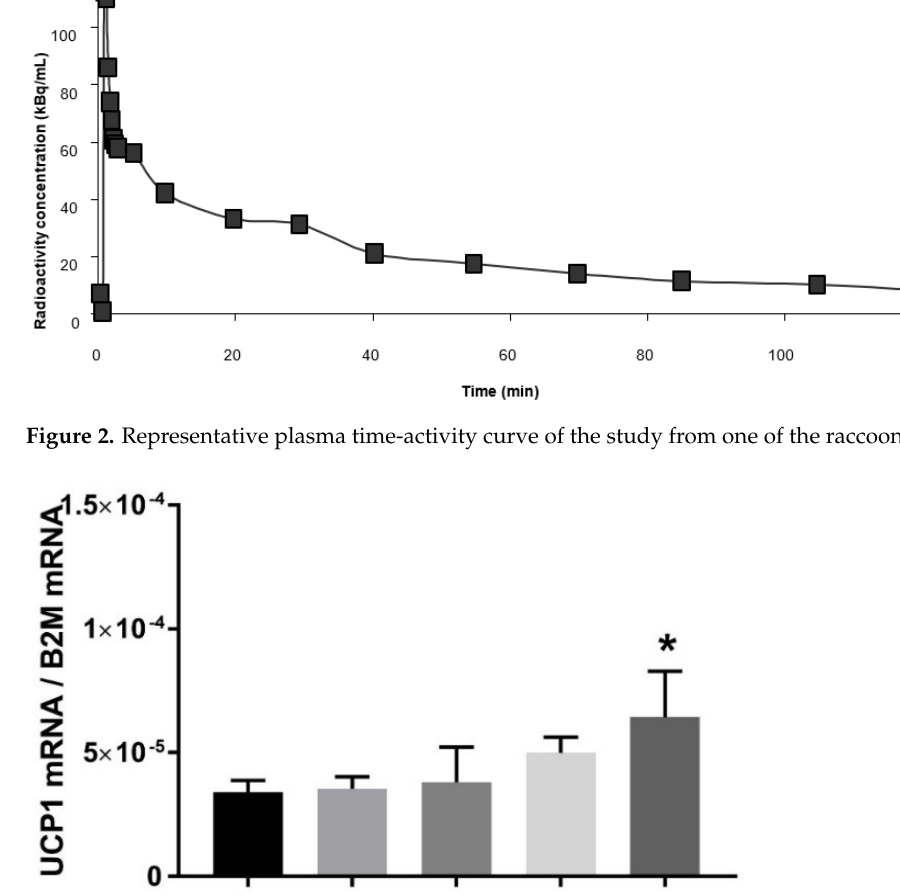
Figure 2. Representative plasma time-activity curve of the study from one of the raccoon dogs.